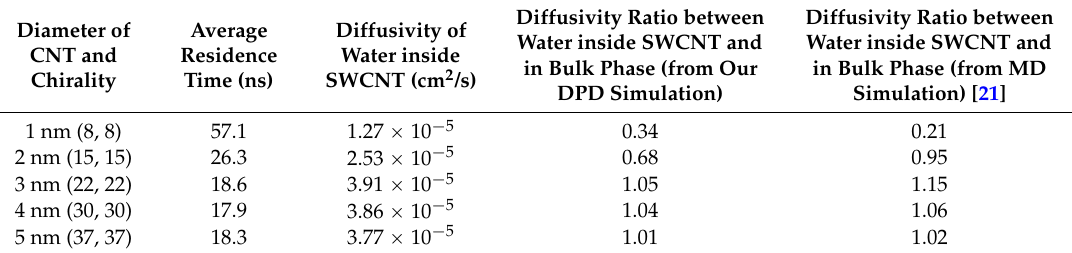
Table 1. Diffusivity and average residence time of water inside